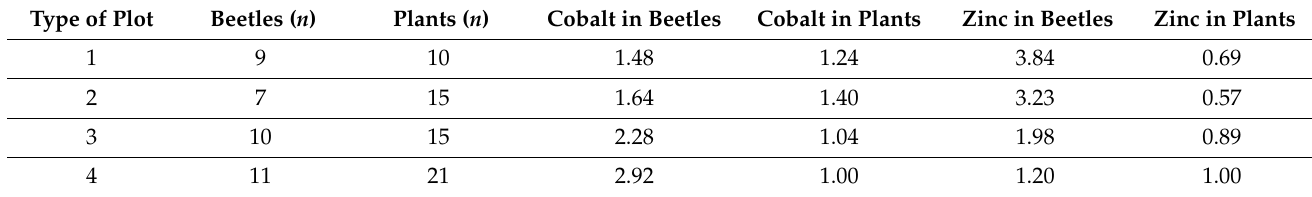
Table 3. Relative concentrations (ratios of plague plot means to control plot means) of cobalt and zinc in plants and beetles within four plots representing different stages of plague activity in jirds ( Meriones tamariscinus and M. meridianus ). Data are modified from Rotshild and Zhulidov, 2000 [31]). Type of Plot Beetles ( n ) Plants ( n ) Cobalt in Beetles Cobalt in Plants Zinc in Beetles Zinc in